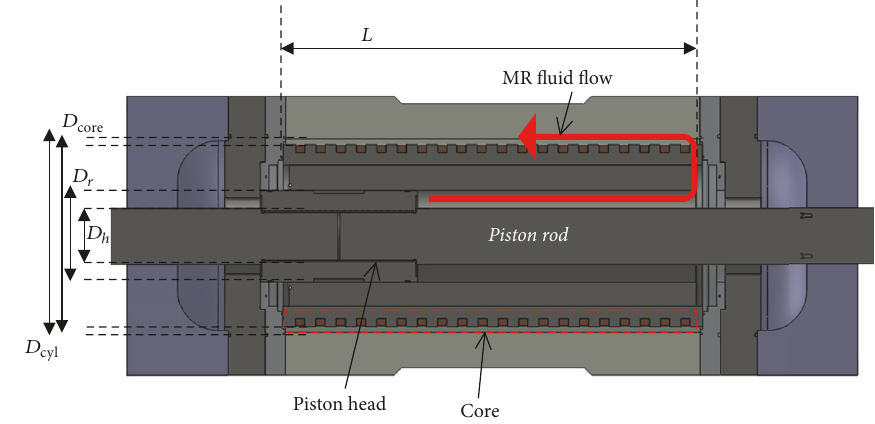
Figure 5: Design configuration of the proposed MR damper. Table 1: Desired profiles of dual shock-waves.